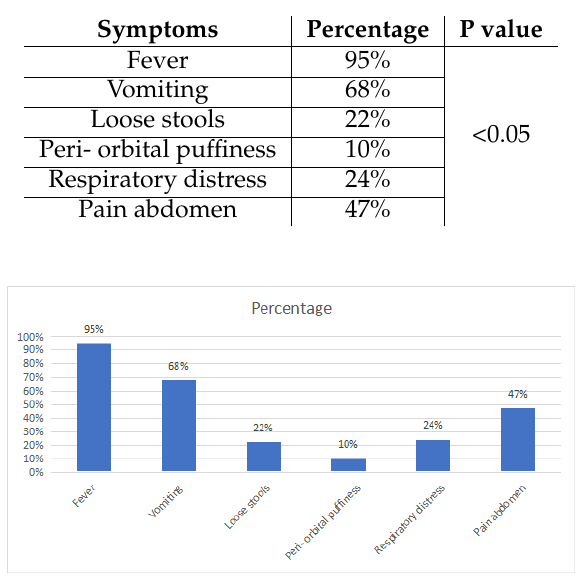
Figure 2. Graphically representation of evaluation of clinical